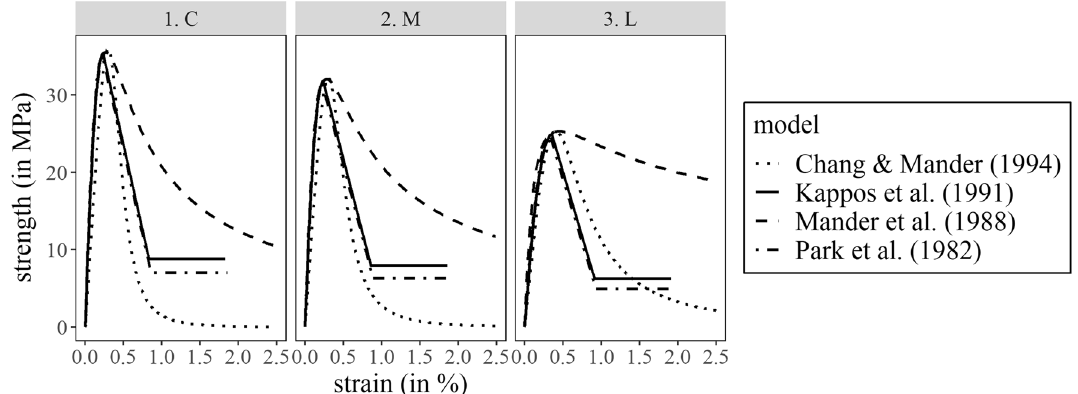
Figure 9. Comparison of experimental vs modelled maximum temperature for the two fire scenarios (i.e., affecting columns M and L) at the location of the 11 thermocouples.